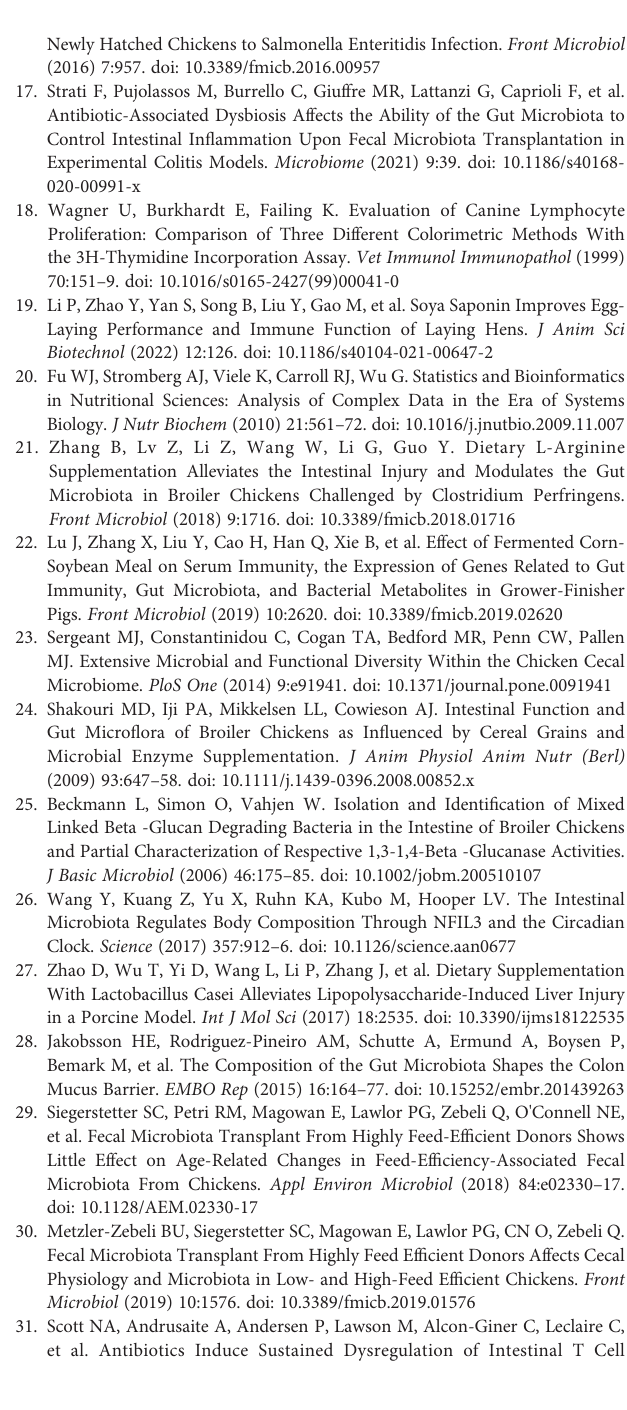
Supplementary Figure 9 | The differential metabolites of ileal chyme in anion mode between thebirds inIBF-CTR and IBF-FMTgroup. Substances that wereup- or down-regulated by IBF compared with the control group were reshaped by FMT, and these substances were marked by red arrows. Supplementary Figure 10 | The differential metabolites of ileal chyme in cation mode between thebirds inIBF-CTR and IBF-FMTgroup. Substances that wereup- or down-regulated by IBF compared with the control group were reshaped by FMT, and these substances were marked by red